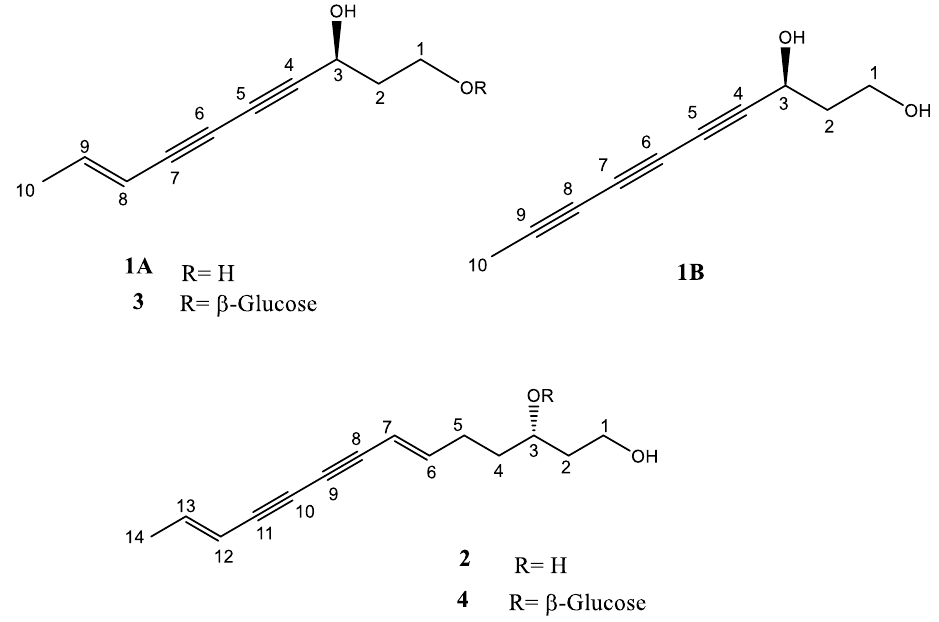
Figure 1. Structures of isolated compounds ( 1A / 1B , 2 – 4 ) from Launaea